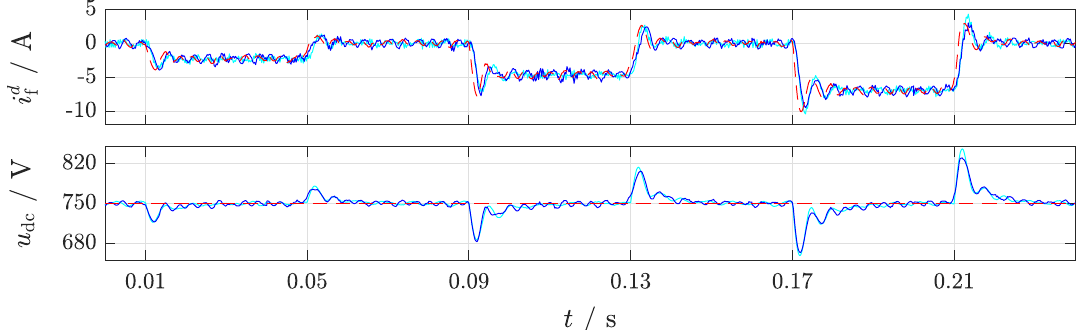
Figure 11. Experiment (E3)—Simulation and measurement results: Time sequence plot of dc-link voltage u dc under different disturbances. [Color code: reference signal, simulated actual value, measured actual